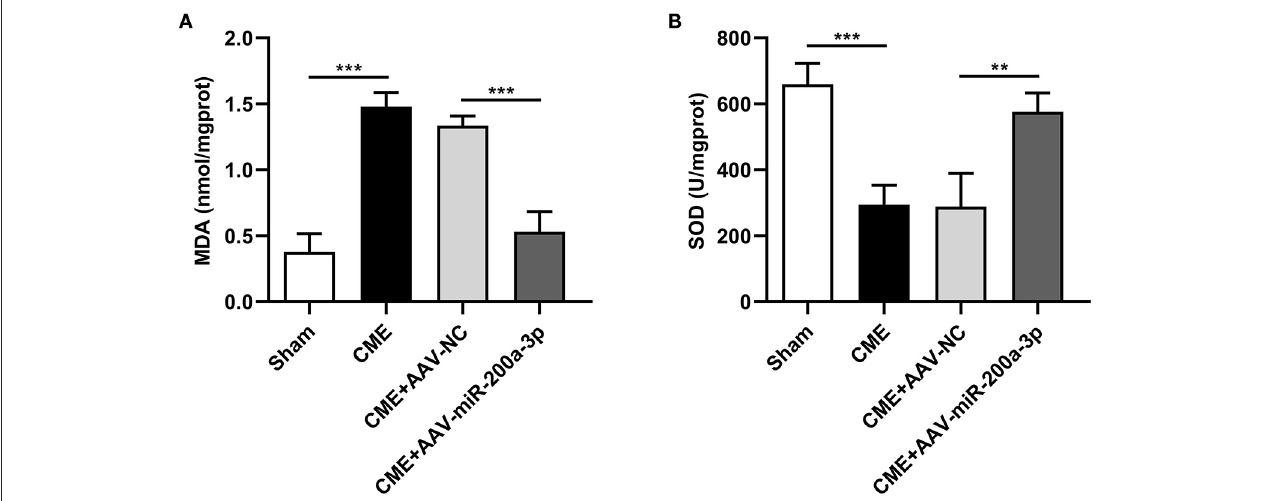
FIGURE 6 | miR-200a-3p overexpression suppresses CME-induced oxidative stress. (A) Myocardial MDA levels were assessed in each group ( n = 4 per group). (B) Myocardial SOD levels were assessed in each group ( n = 4 per group). The data are presented as the mean ± standard deviation (SD). ** P < 0.01, *** P < 0.001. CME, coronary